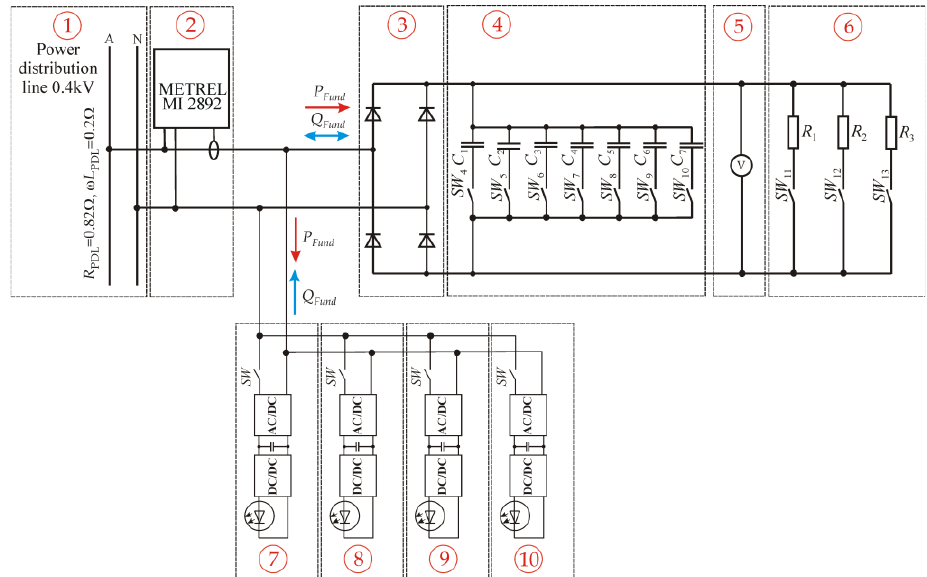
Figure 13. Circuit diagram of experimental setup for the reactive power provided or drawn out by LED light and diode rectifier supply-side devices analysis.